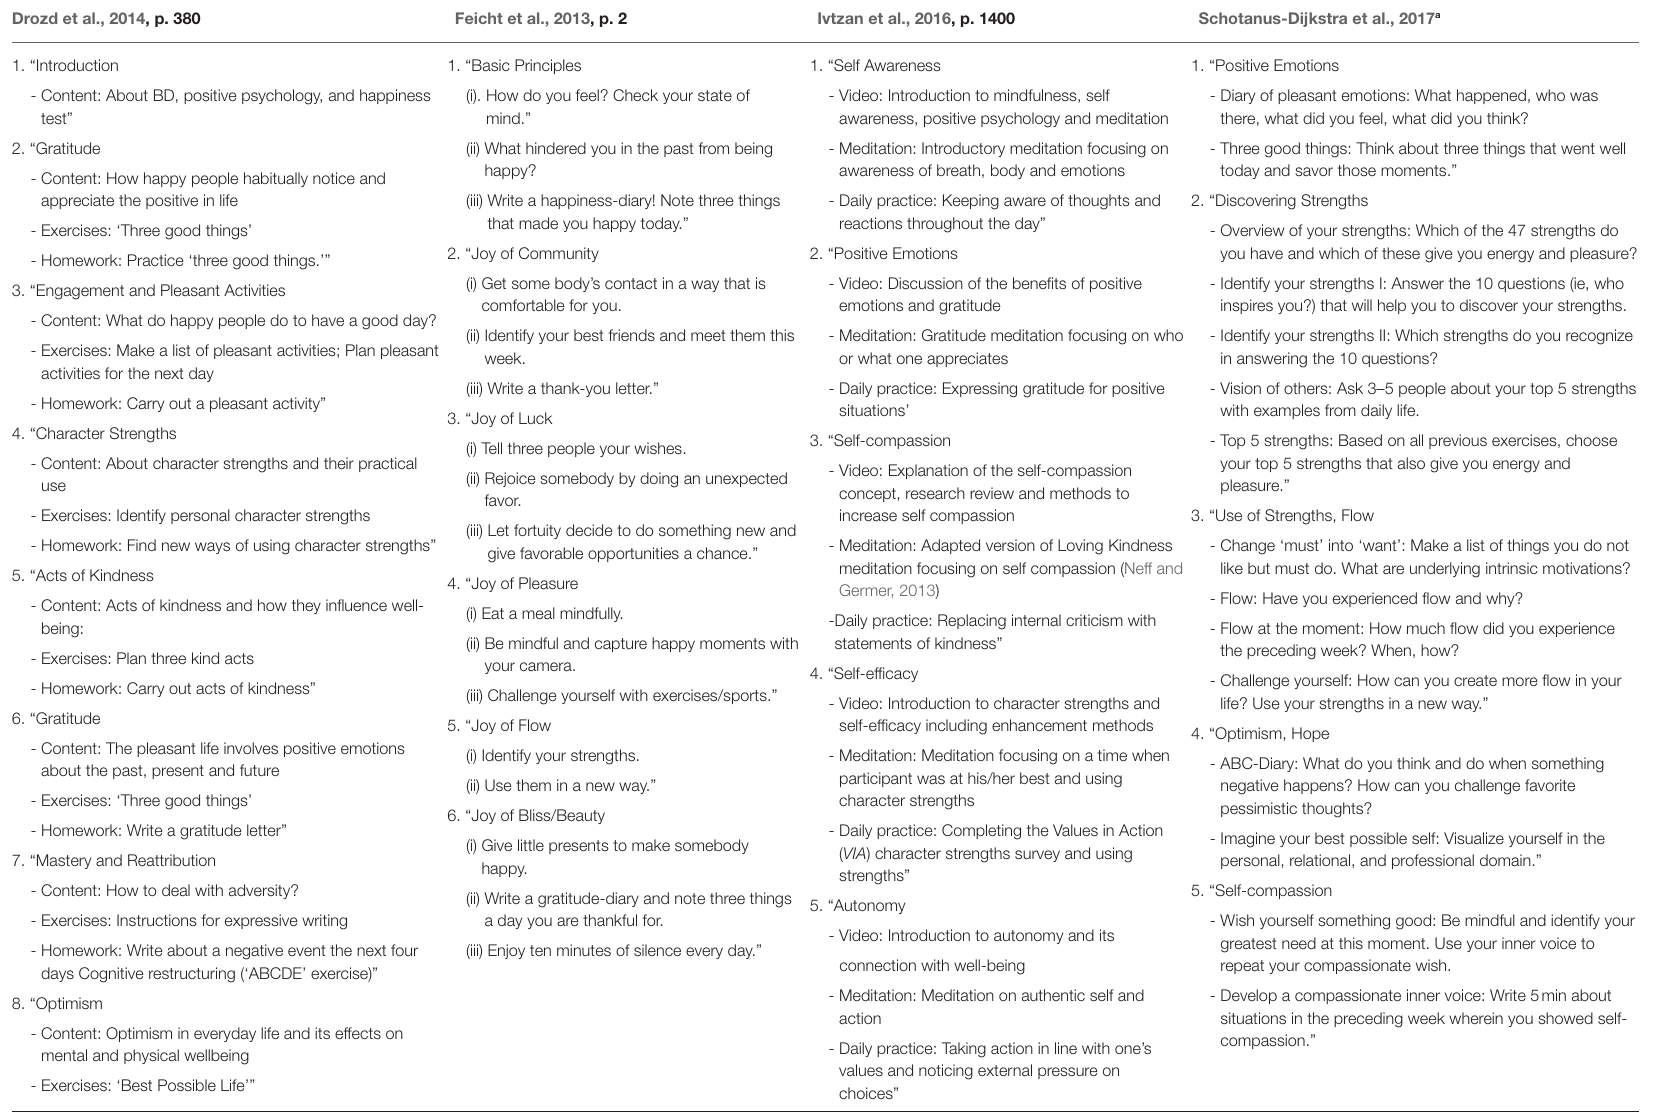
TABLE 4 | The most promising PPI training topics and